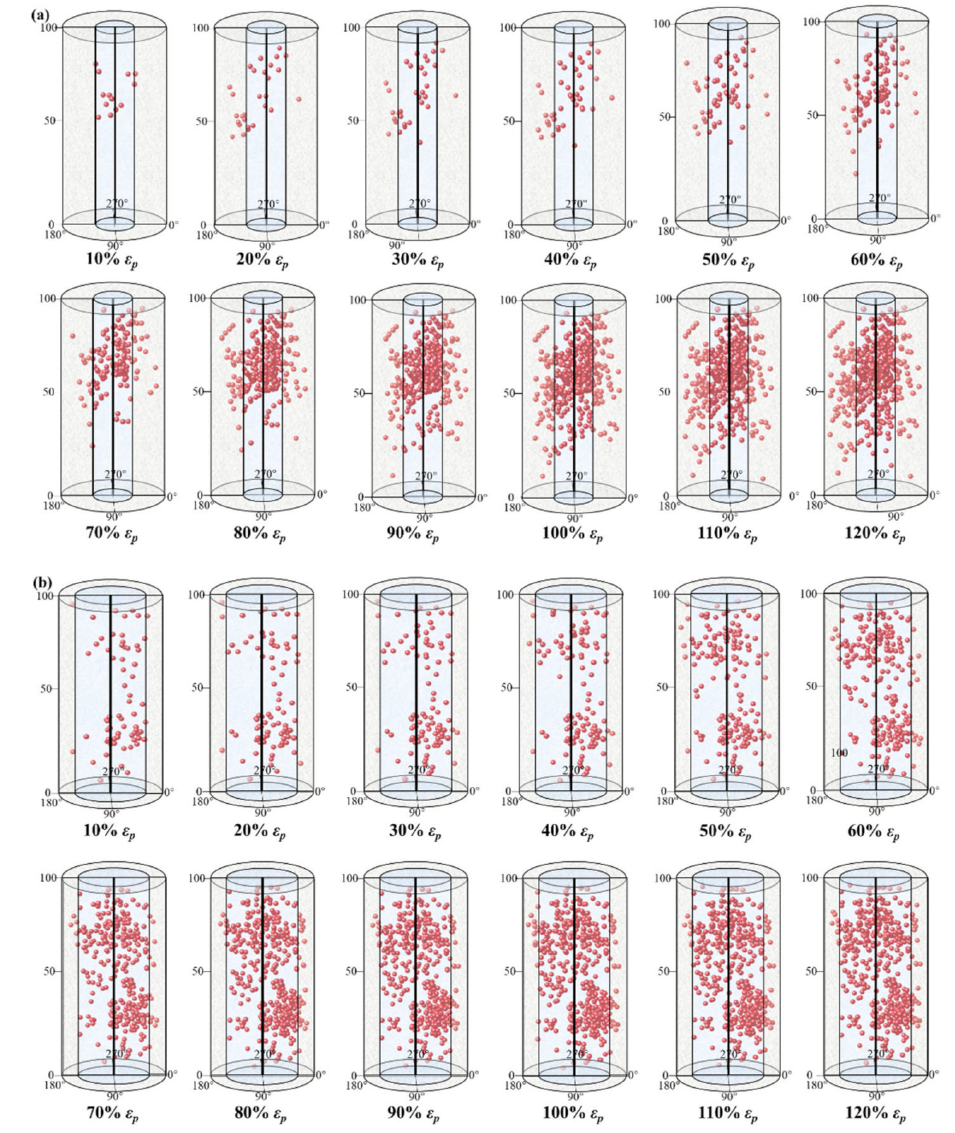
Figure 13. Temporal and spatial evolution of the AE events: ( a ) RBCM-10; ( b )